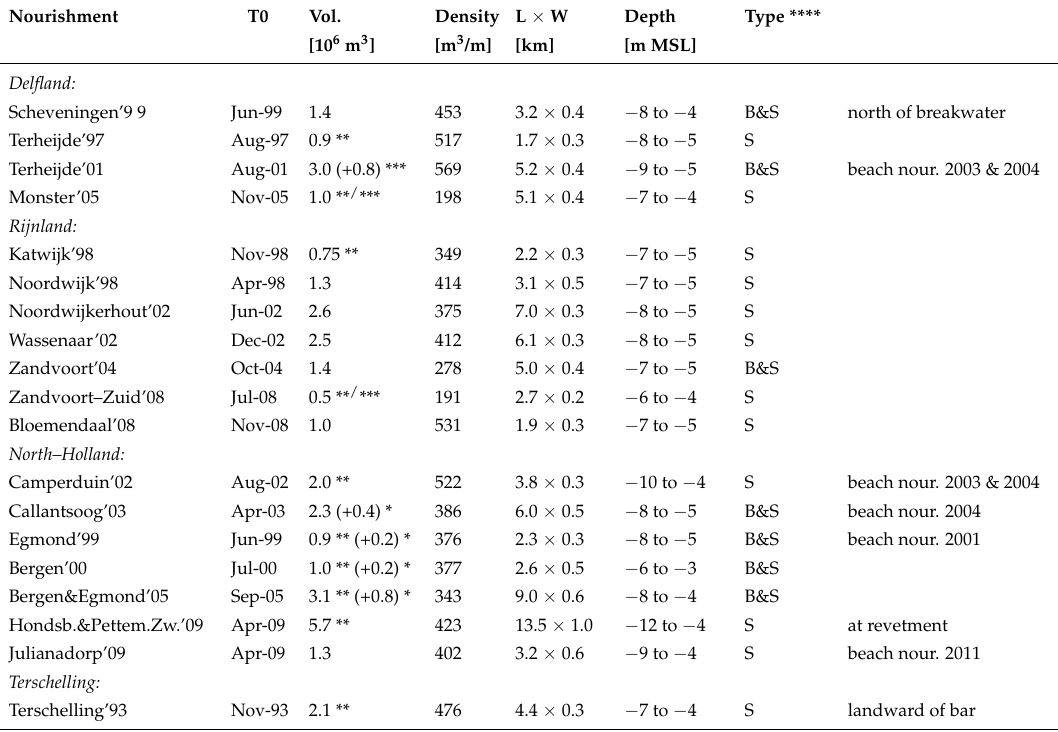
Table 1. Overview of properties of the considered shoreface